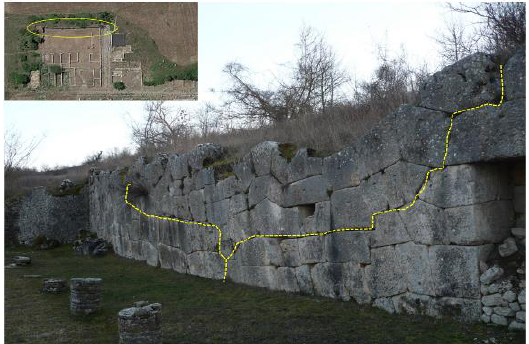
Figure 13. Megalithic wall near of the Imperial house and geotechnics function in preventing landslide: the loss of plumb line with tilting of a wall portion and production of instability phenomena (yellow dashed lines) is reported. The deformation of the wall is well observable even by common aerial application (left top